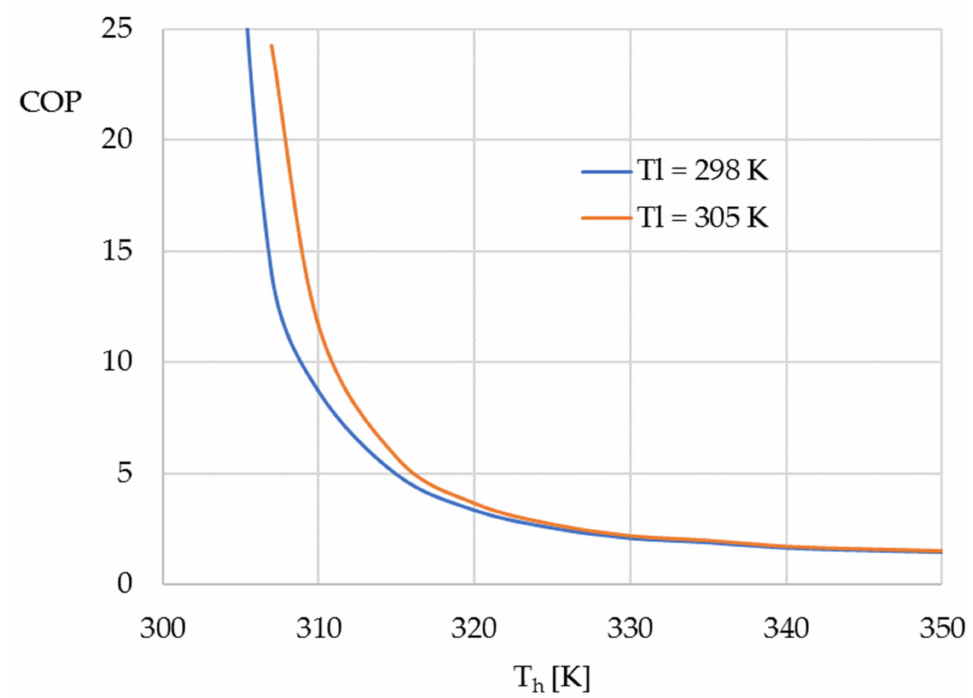
Figure 12. Theoretical COP, calculated with Langevin’s theory of statistical mechanics, as the tem- perature of the hot source T h varies for two different temperatures of the cold source and with H = 5 T.